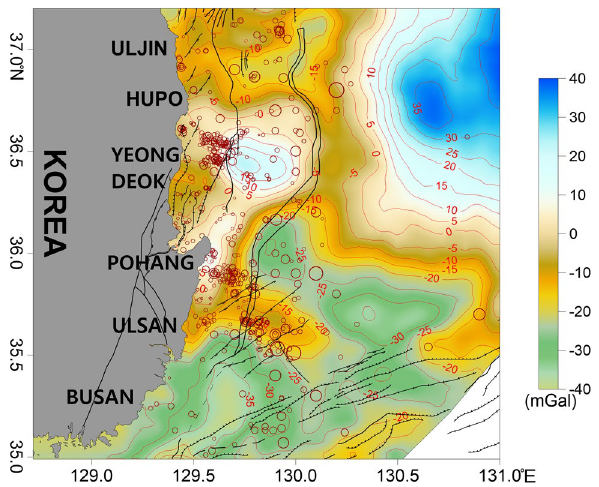
Figure 5. Isostasy gravity anomaly map of the study area. Contour intervals are 5 mGal. The major geologic structures and symbols of the earthquakes are the same as those in Fig. 2. This figure was generated using the Surfer software (https:// www. golde nsoft ware.